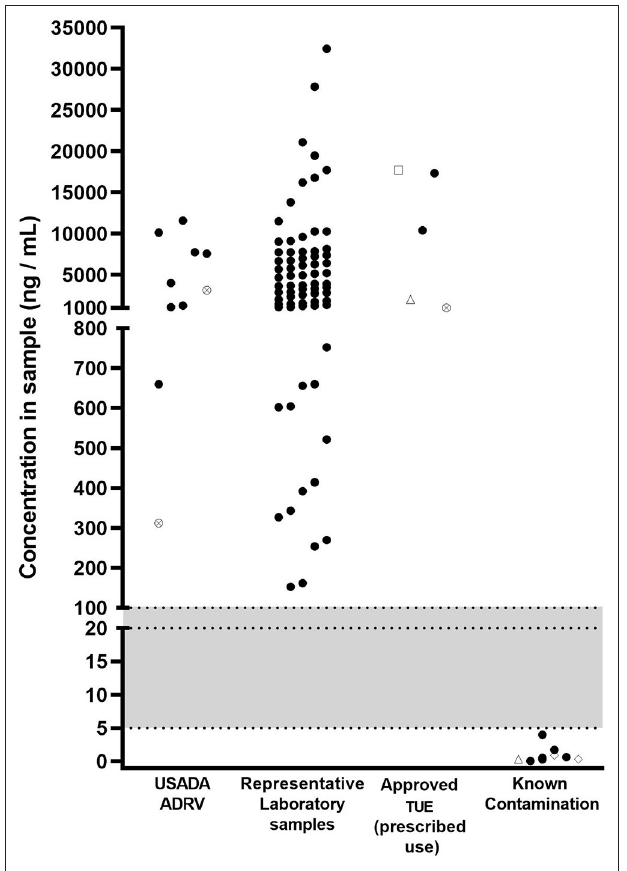
FIGURE 1 | Concentrations of substances [HCTZ (black circles), furosemide (crossed circles), torasemide (open diamonds), triamterene (open triangles), acetazolamide (open square)] in samples returning adverse analytical findings for S.5 (diuretics and other masking agents) between 2017 and 2020. USADA ADRV: refers to samples resulting in an anti-doping rule violation (ADRV); Representative laboratory samples: refers to sample data provided by a laboratory returning Adverse Analytical Findings (AAFs) for HCTZ; Approved TUE (prescribed use): USADA samples where results management determined that the athlete had an approved TUE at the time of sample collection; Known contamination: refers to samples described in the present paper where contaminated medication has been identified as the source. Shaded area indicates a potential range of minimum reporting limit values.